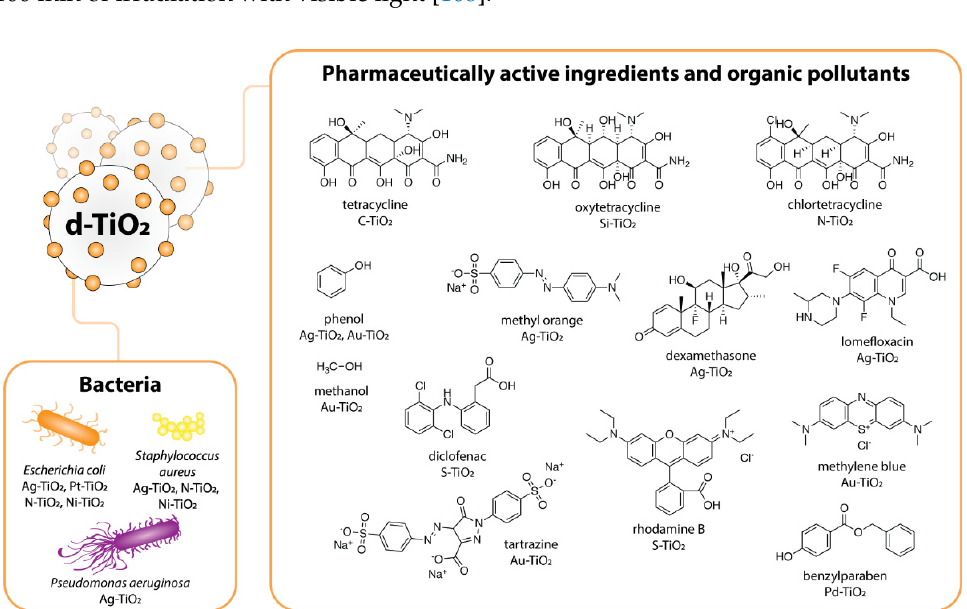
Figure 7. Possible modifications of TiO 2 with other atoms and substances that are decomposed due to the catalytic properties of obtained composites.